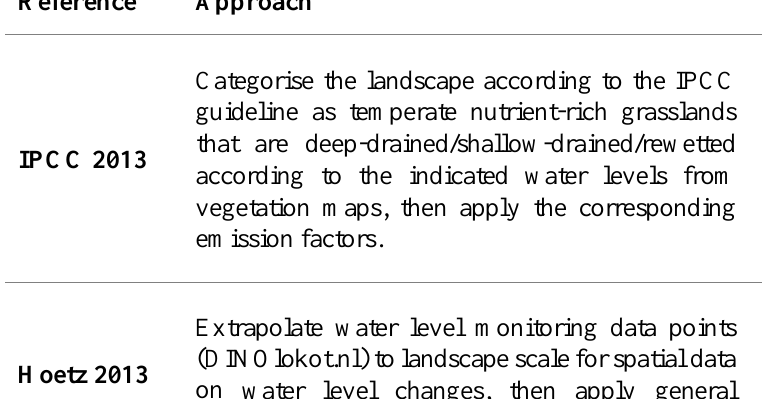
Table 1. Estimation approaches for comparison.